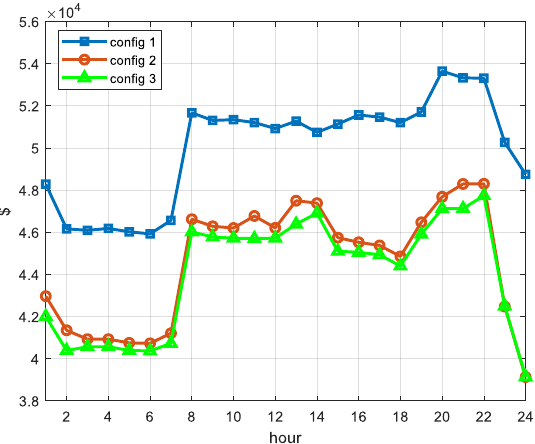
Figure 8. Total costs of scheduled reserves under different system configurations. Table 2. Total operational costs ($) calculated for different system configurations.